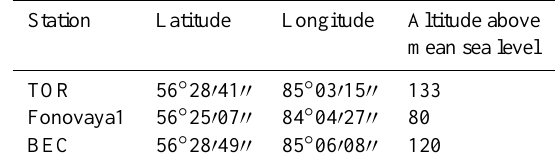
Table 3. Coordinates of the